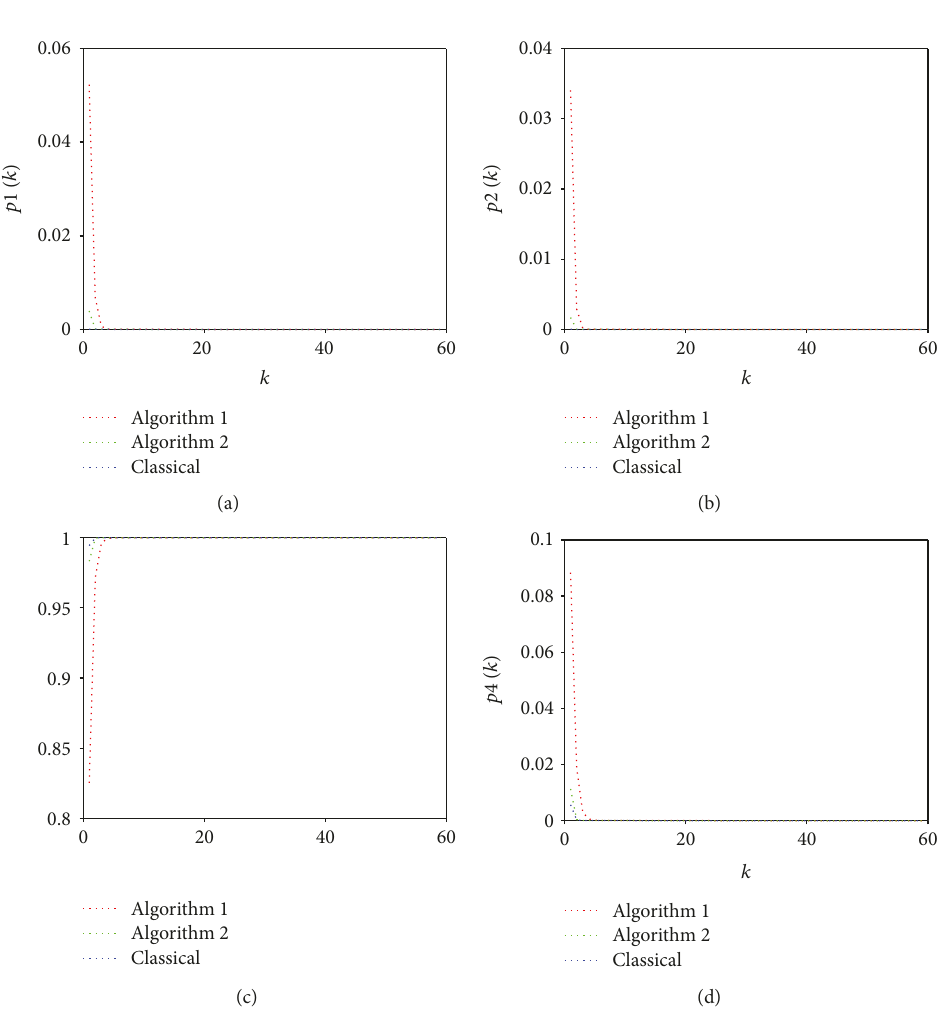
Figure 3: The weight signals of three weighting algorithms in Case